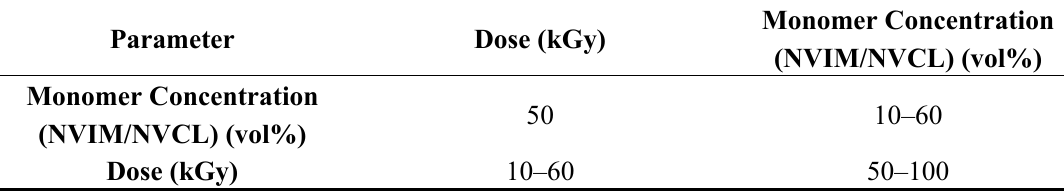
Table 1. Conditions for the synthesis of